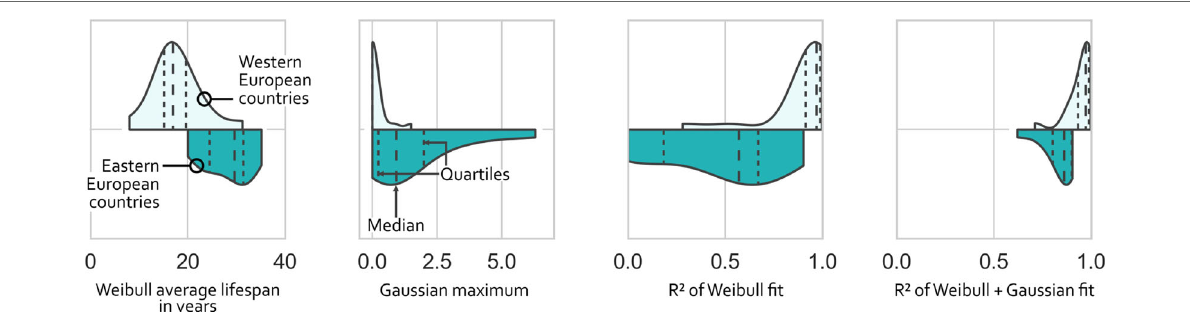
Fig. 4 Difference in fitting parameters for Western and Eastern European countries. The group of Western European countries contains AUT, BEL, CHE, DEU, DNK, ESP, FIN, FRA, GBR, IRL, ISL, ITA, LIE, LUX, MLT, NLD, NOR, PRT, and SWE. The group of Eastern European countries contains CYP, CZE, EST, GRC, HRV, HUN, LTU, LVA, POL, ROU, SVK, and SVN